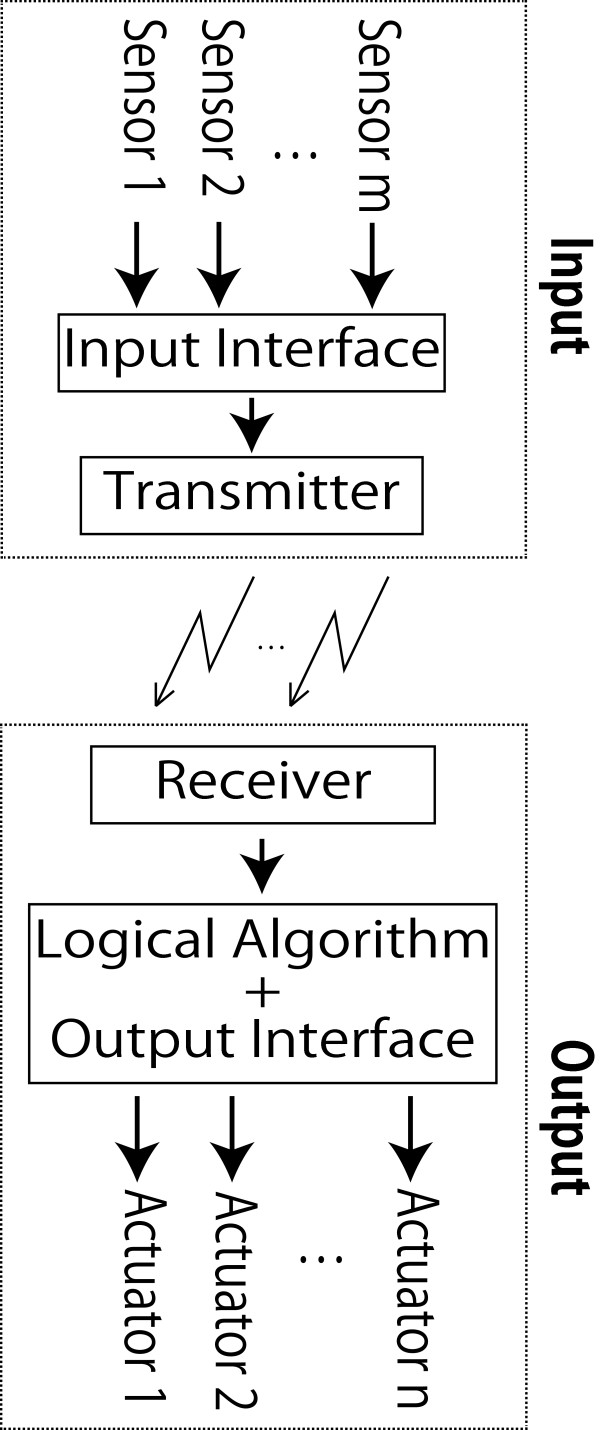
The system lay-out.